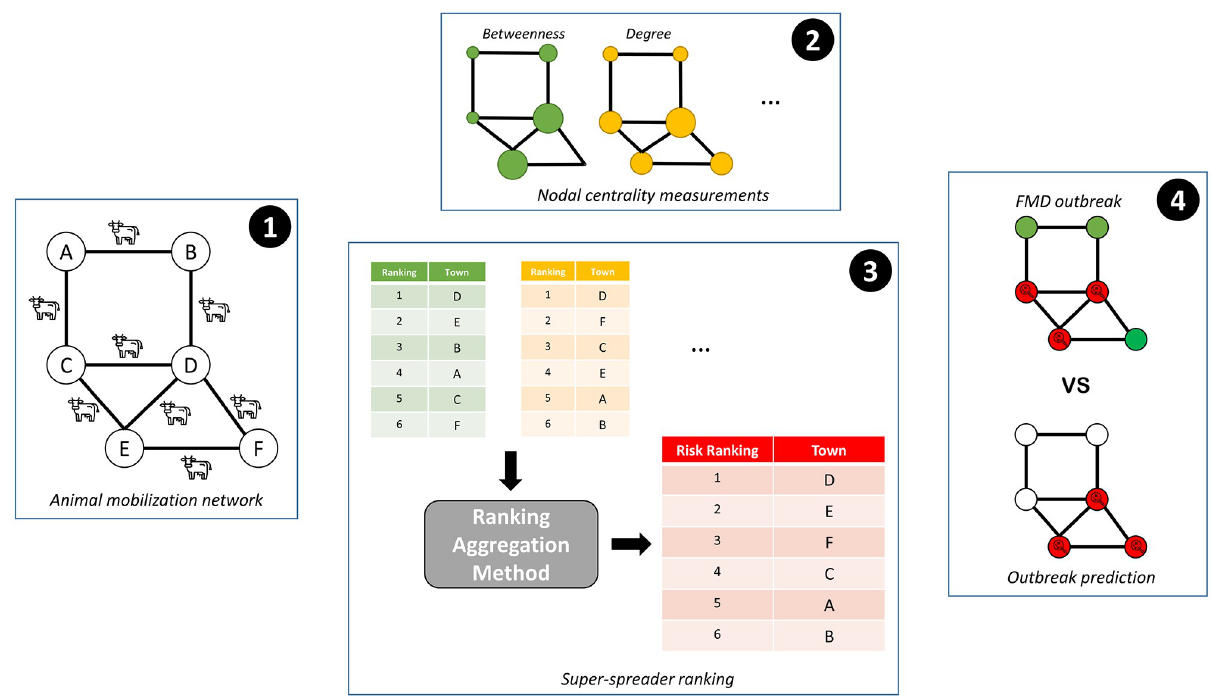
Fig 1. Workflow of the proposed methodology to compute rankings of FMD high-risk areas. First, cattle movement records allowed the construction of livestock mobilization networks. Then, centrality measurements, including betweenness and degree, allowed to build multiple rankings of risk. Next, a unique SSBR resulted from combining these rankings. Finally, based on the SSBR, predictions of possible future outbreaks were computed and compared against an actual FMD